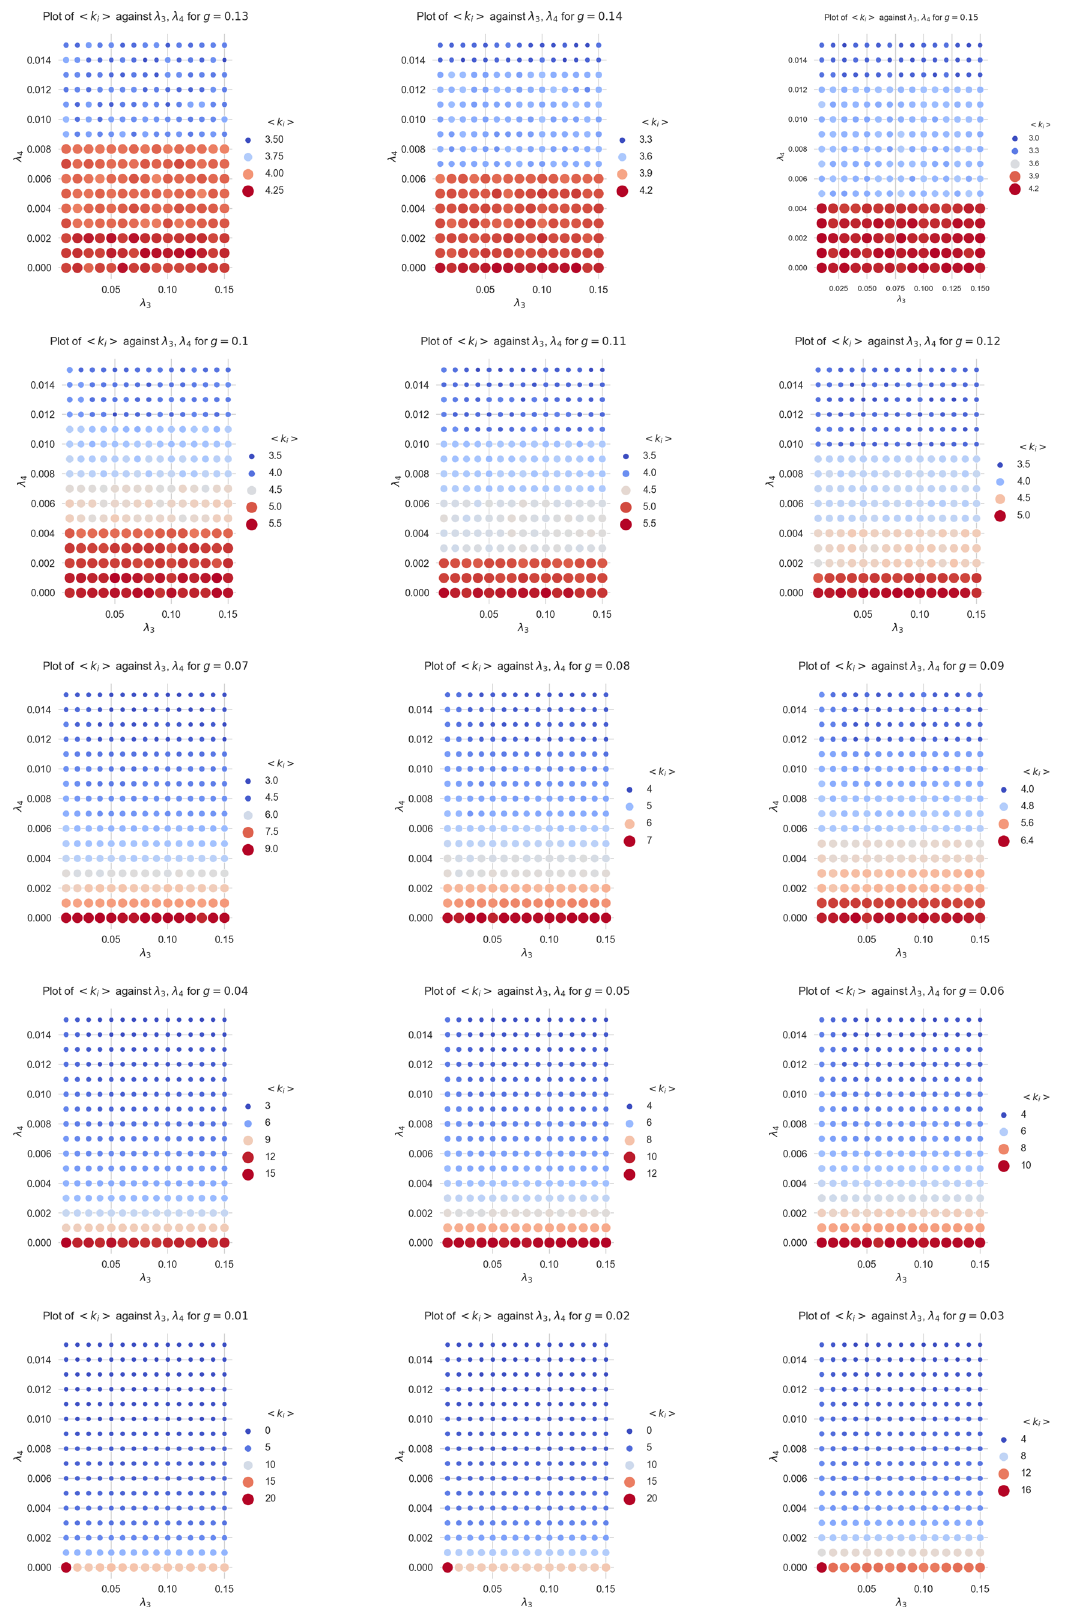
Fig. 10 For a mesh of N = 50 the average node degree is measured computed from the ground state of Eq. (8), across a range of values of λ 3 , λ 4 from 0 . 0 to 0 . 15. Average degree decreases as λ 4 increases, but is constant for fixed λ